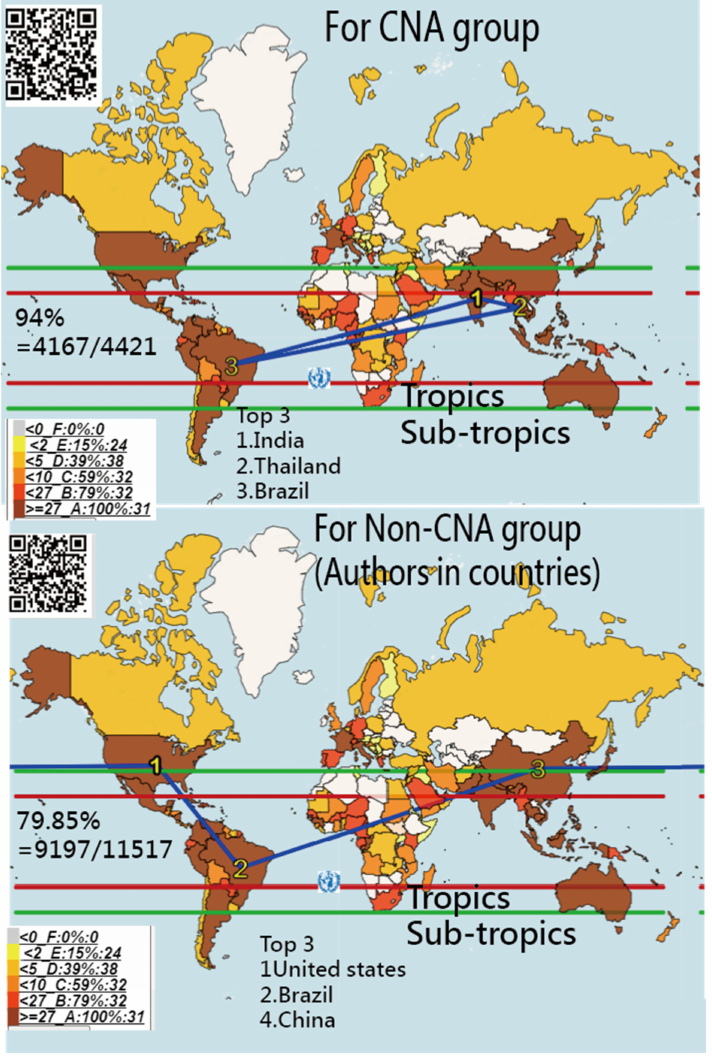
Figure 2. Count numbers of countries/areas in sub-tropics and tropics for the CNA (top) and Non-CNA (bottom) groups; the darker color means more numbers in